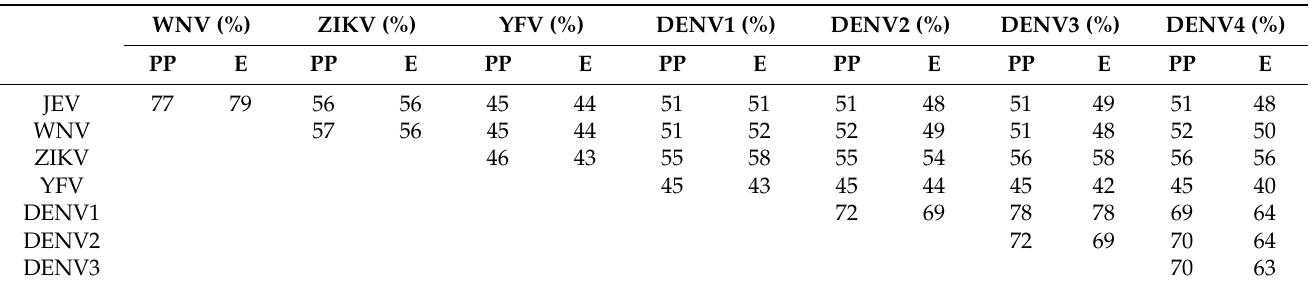
Table 1. Identity analysis of amino acid sequences based on the polyprotein and the envelop protein of five mosquito-borne